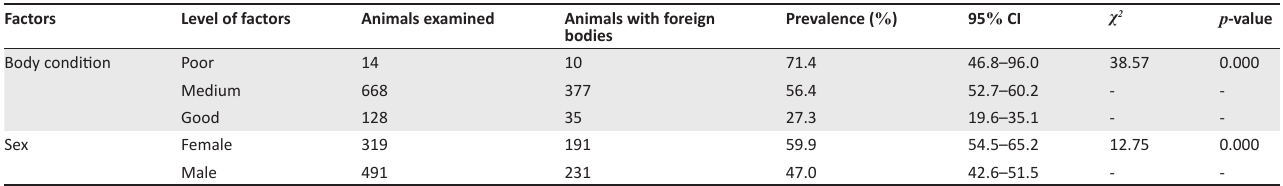
TABLE 4: Prevalence of foreign bodies in relation to sex and body condition of cattle and small ruminants. Factors Level of factors Animals